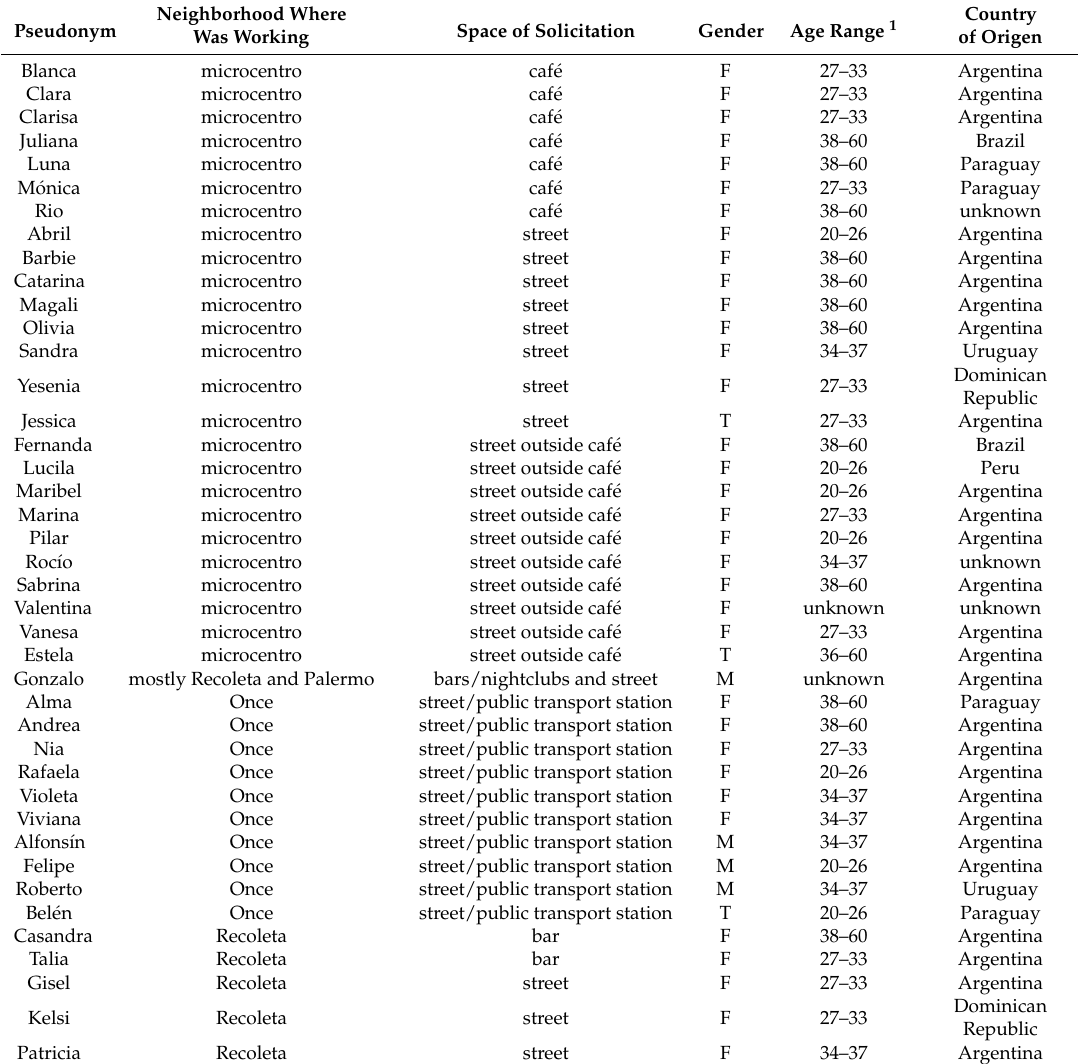
Table A1. Personal interviews with sex workers in Buenos Aires, Argentina.